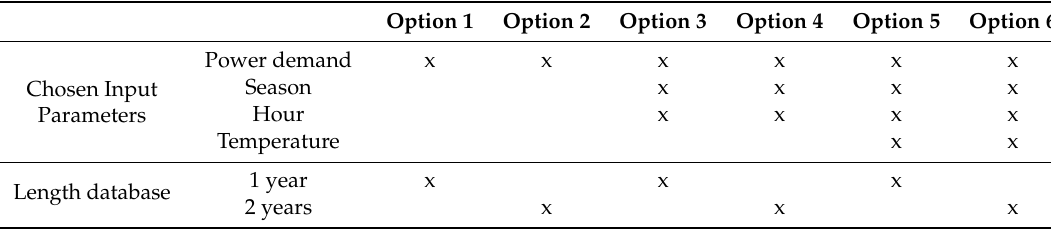
Table 2. Proposed options for the final energy